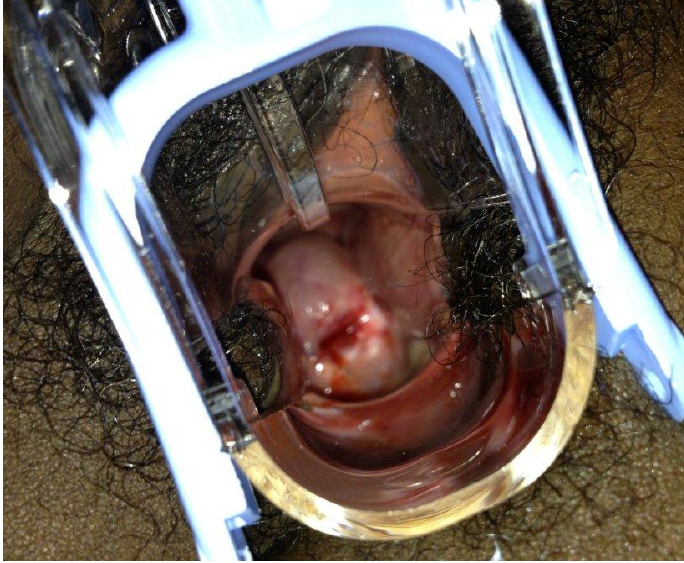
Figure 3. Visualization of cervix with acetic acid reveals white patches indicating cervical